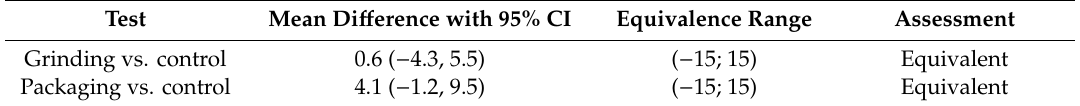
Figure 4. Distribution of the DASH score in the three groups. Table 5. Results of the TOST-based tests.